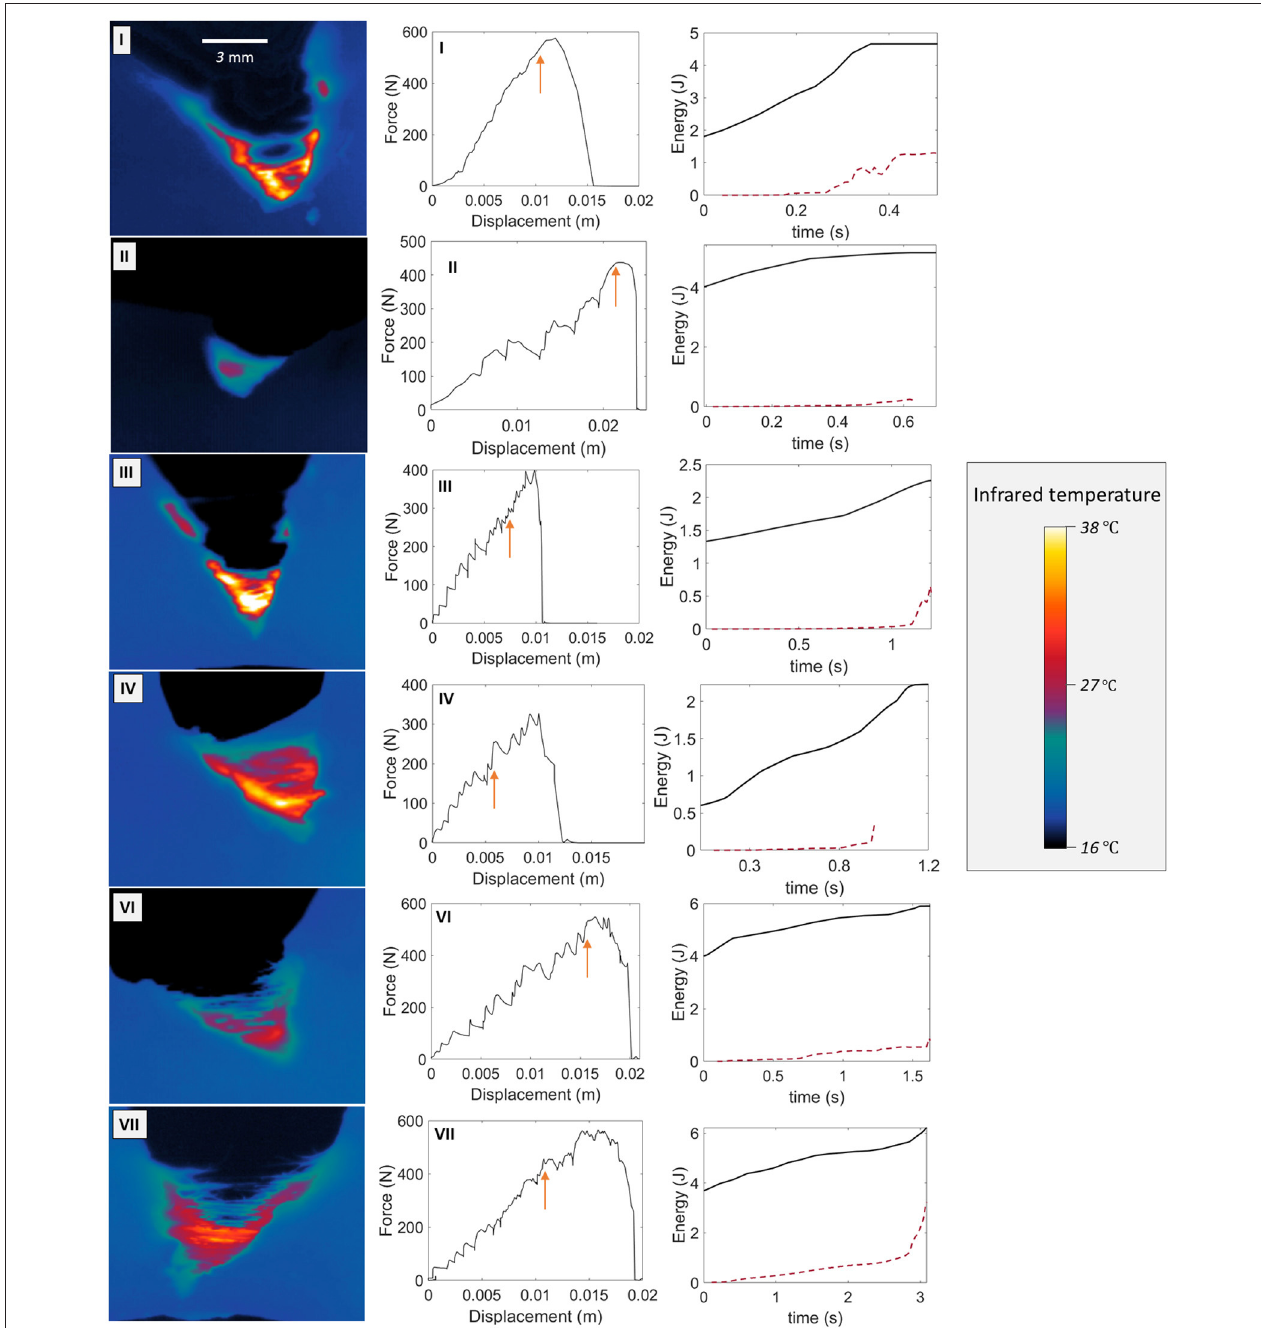
FIGURE A1 | Temperature map examples (first column), force vs. displacement curves (second column), and time evolution of W and U (plain and dashed plot, respectively, third column) from the onset of the rupture (arbitrarily at t onsets of